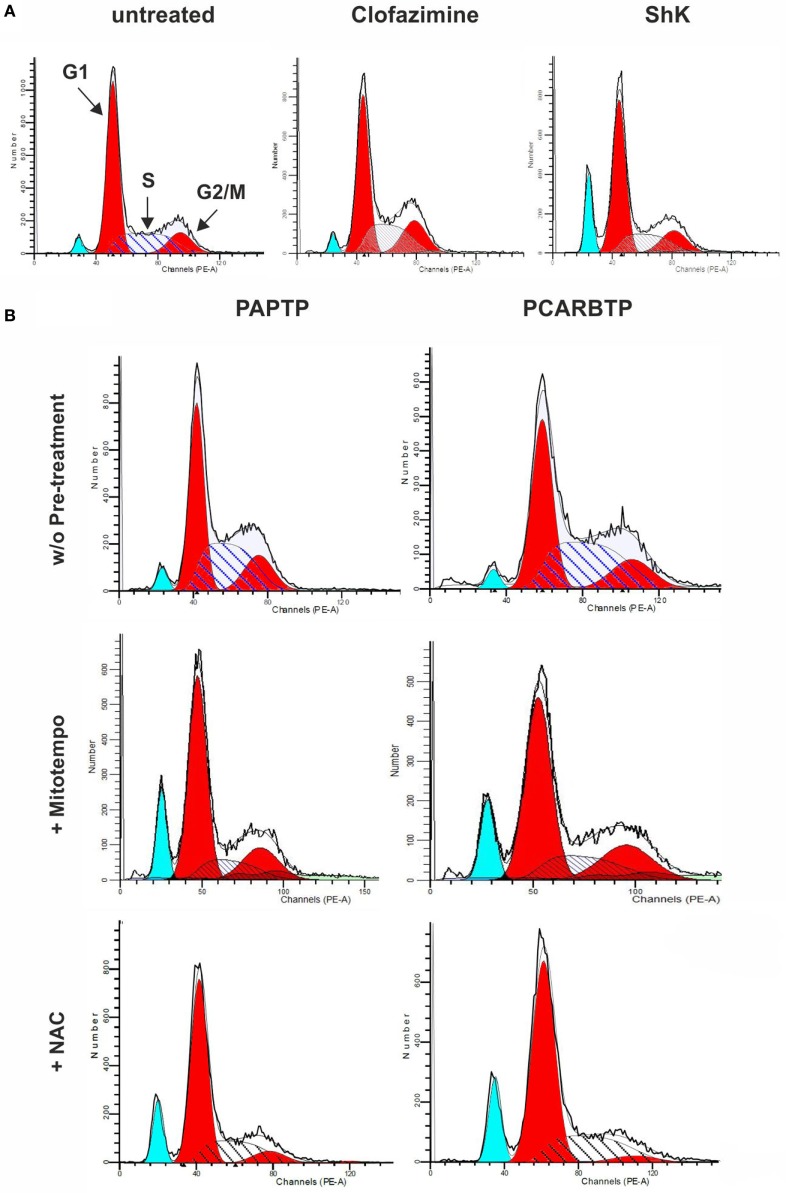
Sublethal inhibition of mitochondrial Kv1.3 leads to cell cycle alterations. (A) FACS analysis of cell cycle of PANC-1 cells untreated or treated with clofazimine 1 µM and ShK 100 nM for 24 h. The distribution was determined by staining cells with 50 µg/mL Propidium Iodide and the acquisition was performed by a FACSantoII (Beckton Dickson). The plots are representative of three separated determinations. Light blue peaks represent apoptotic cells, while red peaks represent cells in G1 and G2/M phases. S phase is represented by the area with blue straight lines. A sub-G1 peak is due to dead cells. In the graph of untreated cells the labels and the arrows identify the different populations that are reported. (B) Cell cycle distribution in PANC-1 cells pretreated (lower panels) or not (upper panels) with 50 µM Mitotempo or 20 mM N-acetylcysteine (NAC) for 1 h, before the addition of mitochondrial Kv1.3 inhibitors PAPTP and PCARBTP (both at 100 nM) for 24 h. The experiment and the analysis have been performed as in (A). The plots are representative of three separate measurements.